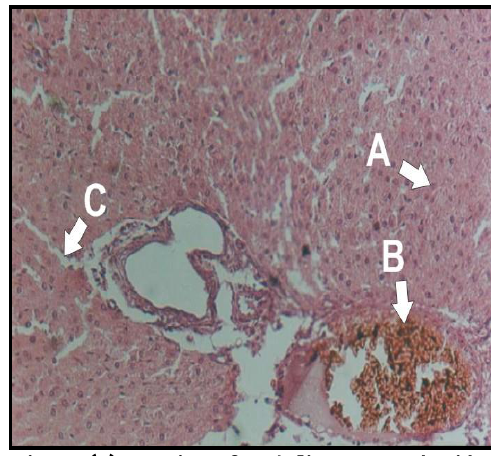
Figure (5): Section of rat's liver showing the effect of pre-treatment with 100mg.kg - 1 .day 1 PTX for 14 days prior to CCl -A: Mild steatosis -B: Mild sinusoid dilatation. -C: Normal hepatocyte. Magnification: (10*10); staining: Haematoxylline and Eosin.